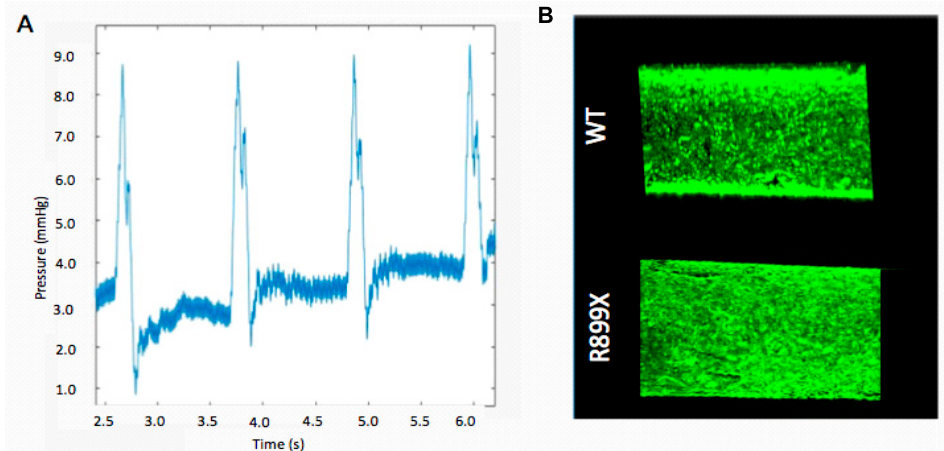
Figure 2. Validation of mechanical and cellular properties. ( A ) Sample waveform depicting the oscillatory pressure waves observed within the center of the channel. ( B ) WT and mutant Bmpr2 R899X endothelial cell channels imaged at 5× with fluorescent calcein AM to observe the monolayer formed by the cells. Channels were imaged after perfusion to ensure that the endothelial monolayer remained intact after the flow experiments. Cells were removed from conditional immortalization and the transgene was activated though doxycycline.